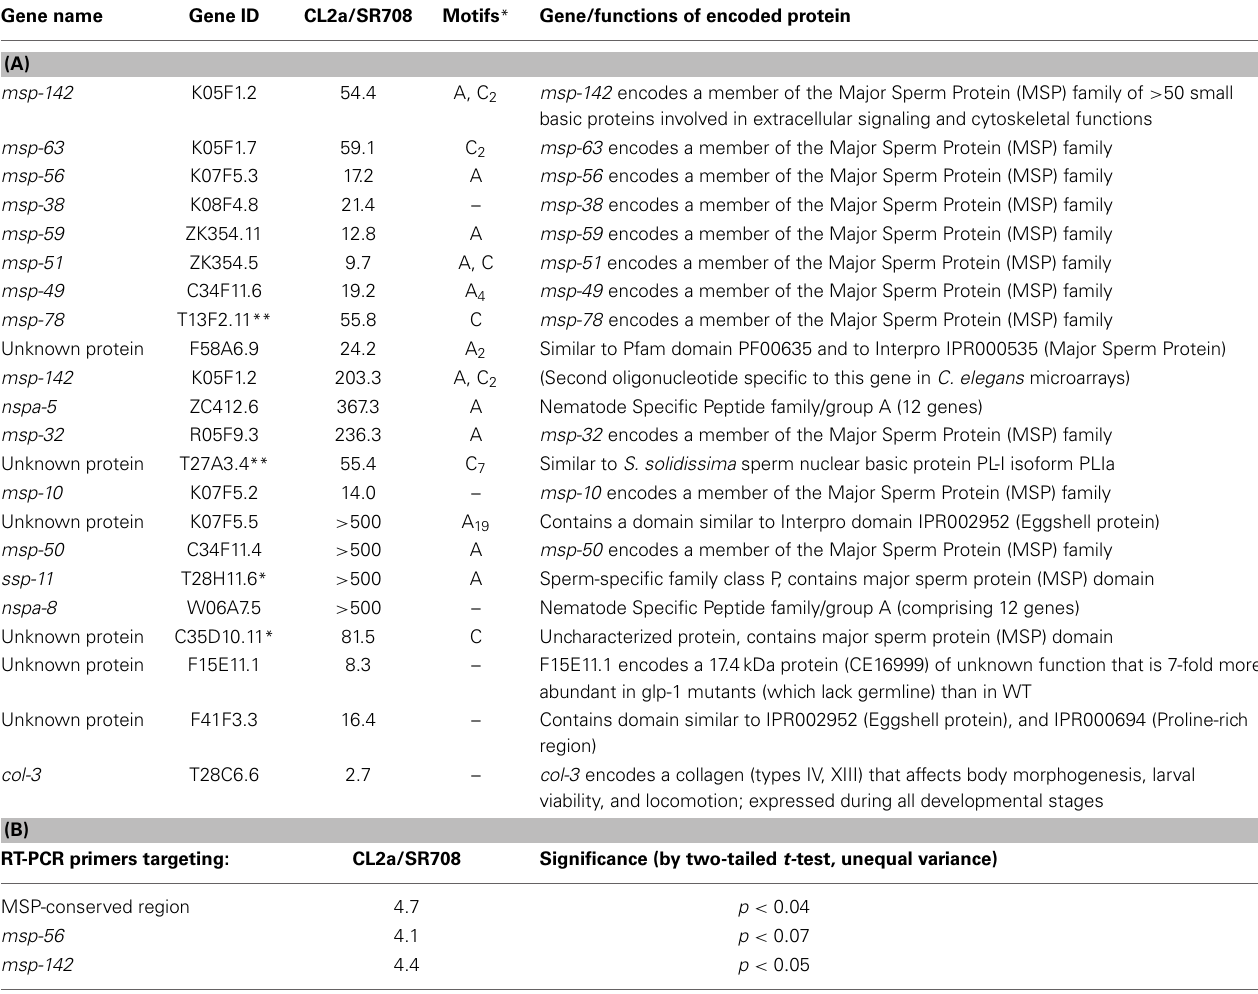
Table 1 | Genes with highly differential expression dependent on the lsq4